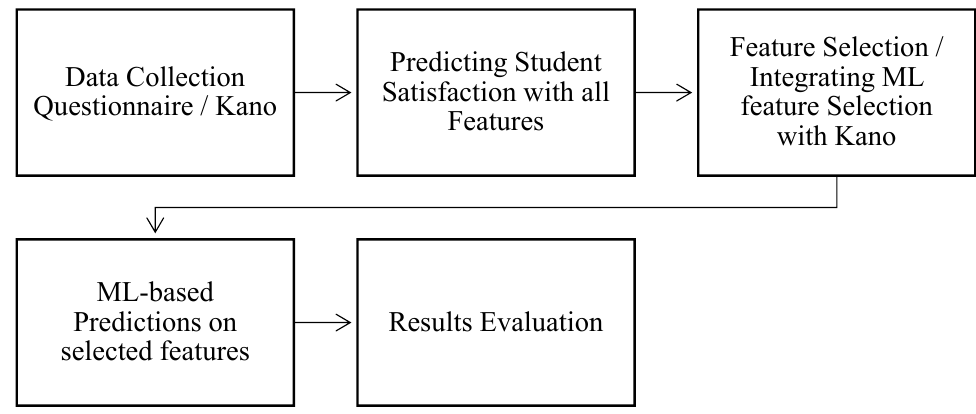
Figure 2. Proposed Figure 2. Proposed Methodology.